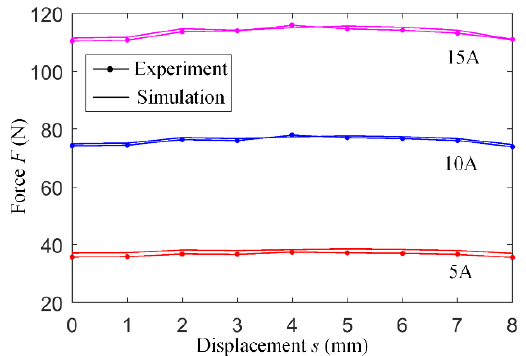
Figure 14. Electromagnetic force characteristic curve of the EMLA.